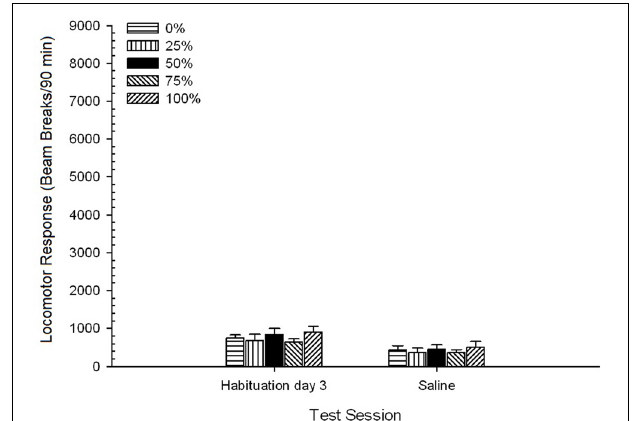
FIGURE 8 | Mean (SE) locomotor response (number of beam breaks in an electronic array per 90min) on the last of 3 drug-free habituation sessions and on a subsequent session after saline injection (i.p., 1ml/kg) in groups of Lewis rats ( n = 8/group) previously exposed to 15 daily conditioning sessions with sucrose reward (10% solution) delivered under 0, 25, 50, 75, or 100% variable schedules. The conditioned stimulus was a light (120s). Group 0 received the same number of rewards as group 100 in the absence of conditioned